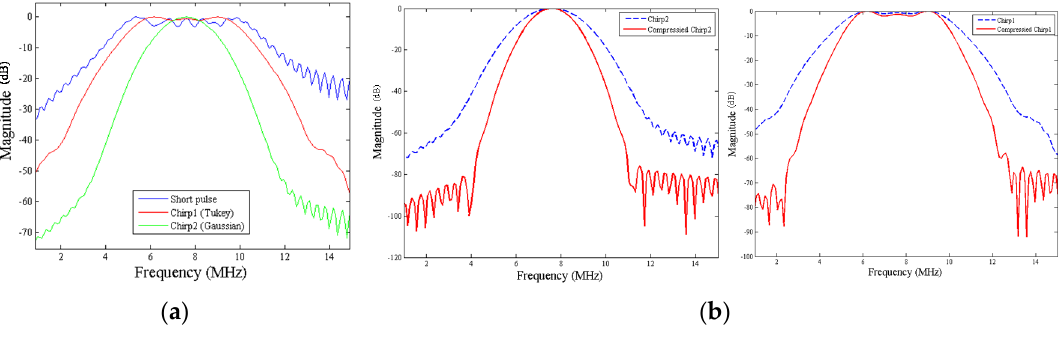
Figure 7. ( a ) Frequency responses before matched filter; and ( b ) frequency responses of Gaussian and Tukey after matched filter.